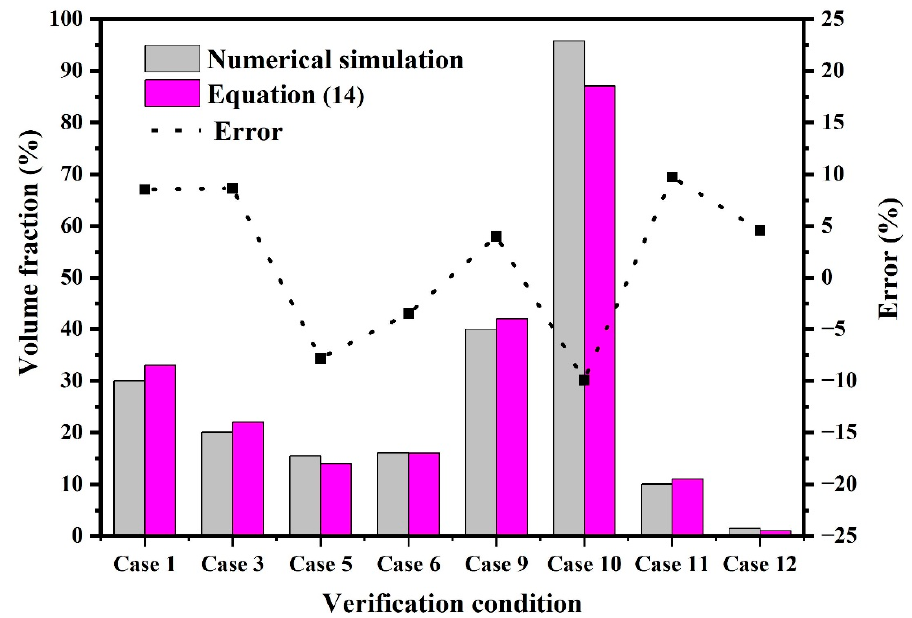
Figure 15. Validation of gas concentration prediction model in confined